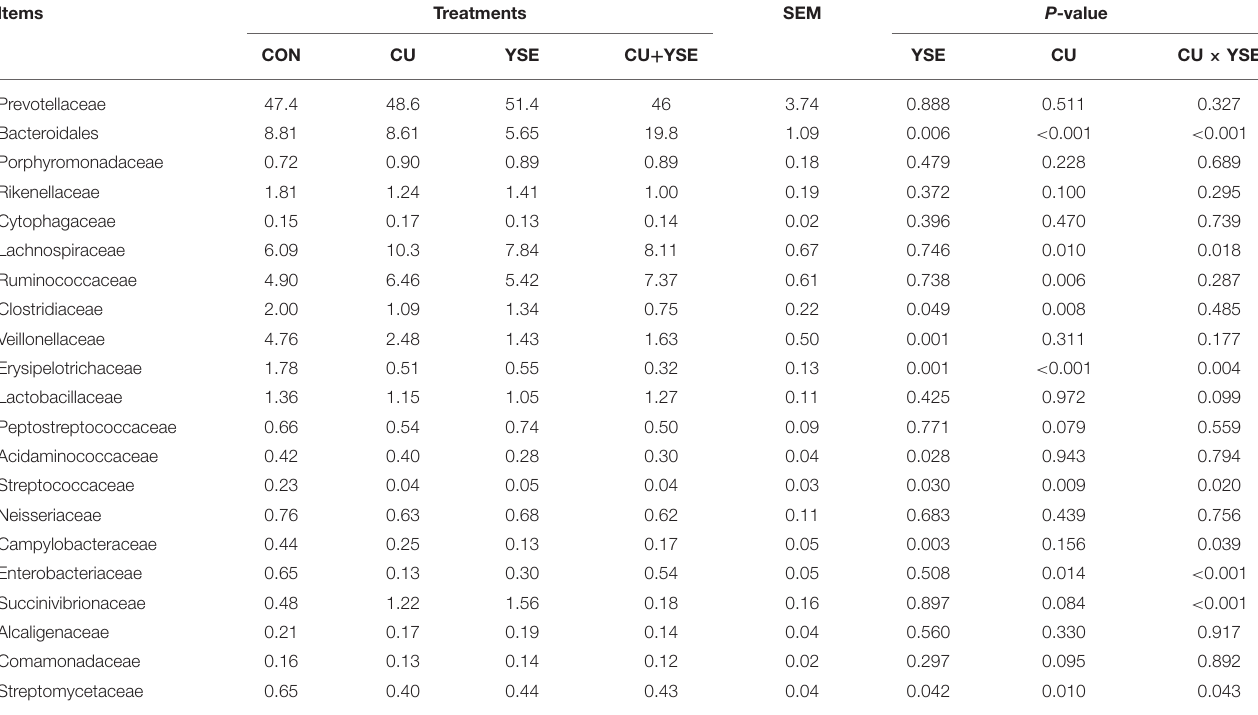
TABLE 9 | Effects of dietary YSE and oral CU on the relative abundance of caecum microflora at family